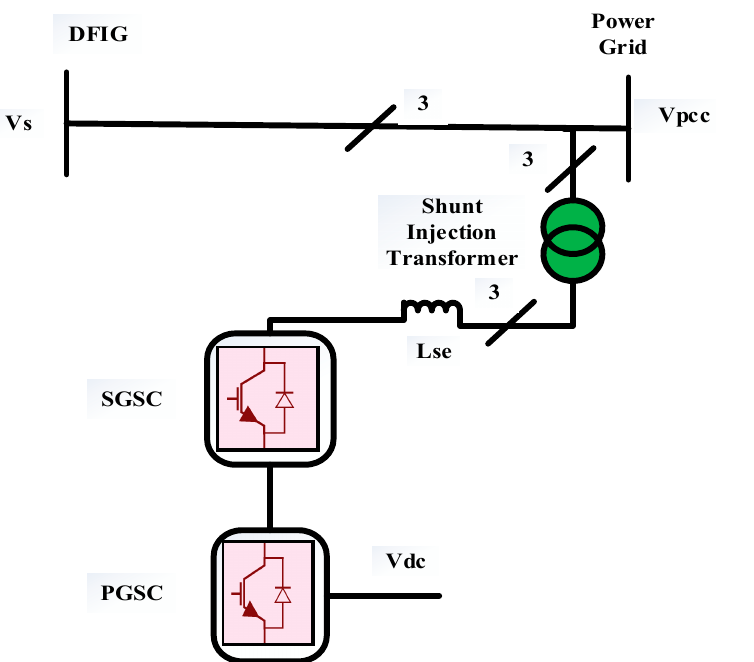
Figure 5. Schematic diagram of a shunt-transformer-interfaced SGSC.